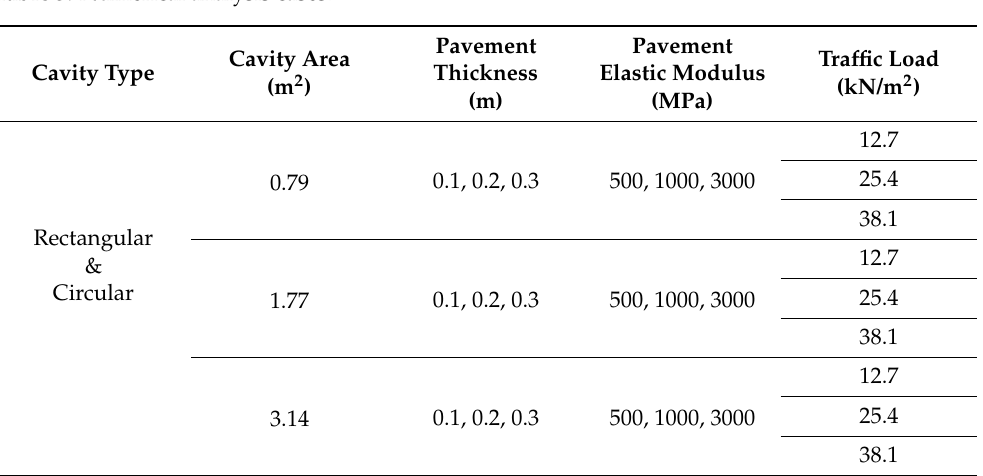
Table 3. Numerical analysis